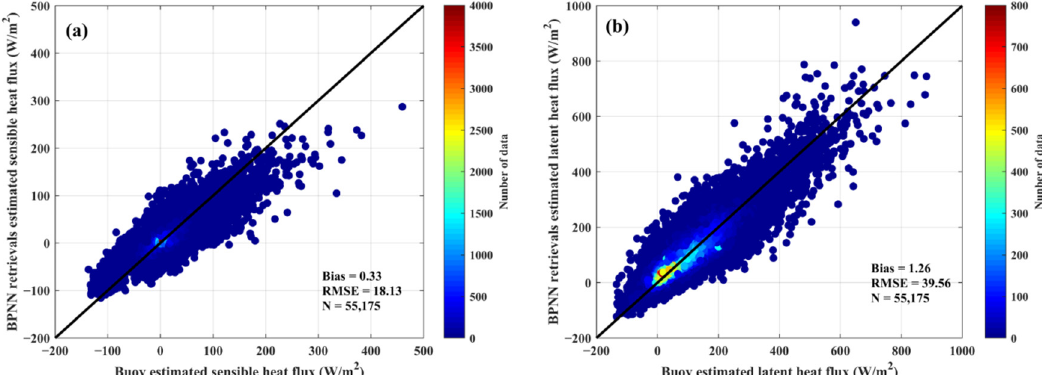
Figure 6. The comparison between the estimated heat fluxes from COARE 3.5 and BPNN-retrieved air–sea interface parameters (WS, T s , T a , RH), and those from buoy and ECMWF ERA5 data over the global oceans, for 55,175 data points from 2012 to 2020: ( a ) sensible and ( b ) latent heat flux. The colored bars represent the number of data points in the specific bin. The bin size is 5 × 5 W/m 2 for ( a ) and 10 × 10 W/m 2 for ( b ). Each colored point is located at the center of the bin.